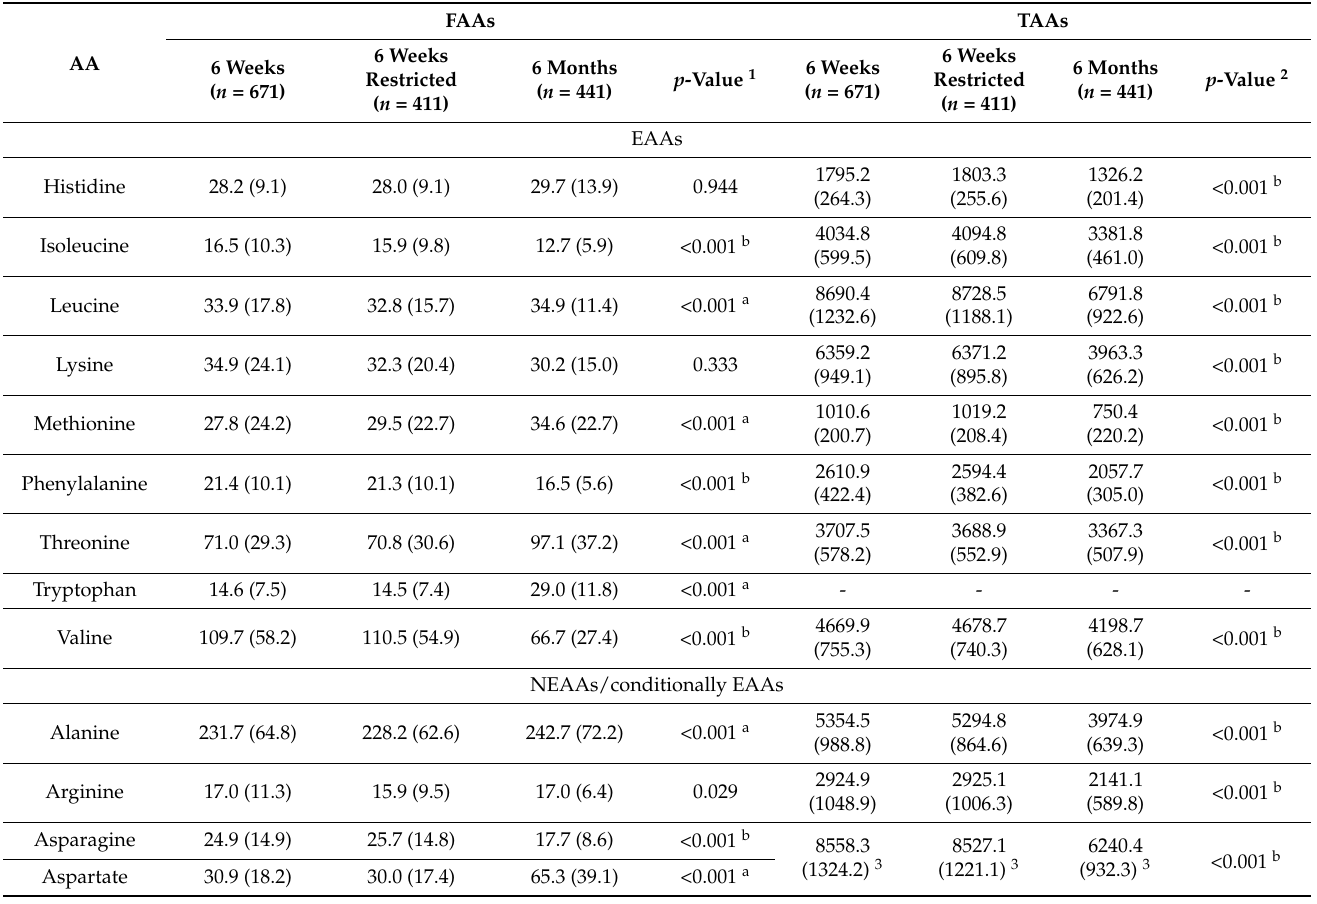
Table 2. Free amino acid and total amino acid levels in human milk sampled at 6 weeks and 6 months of